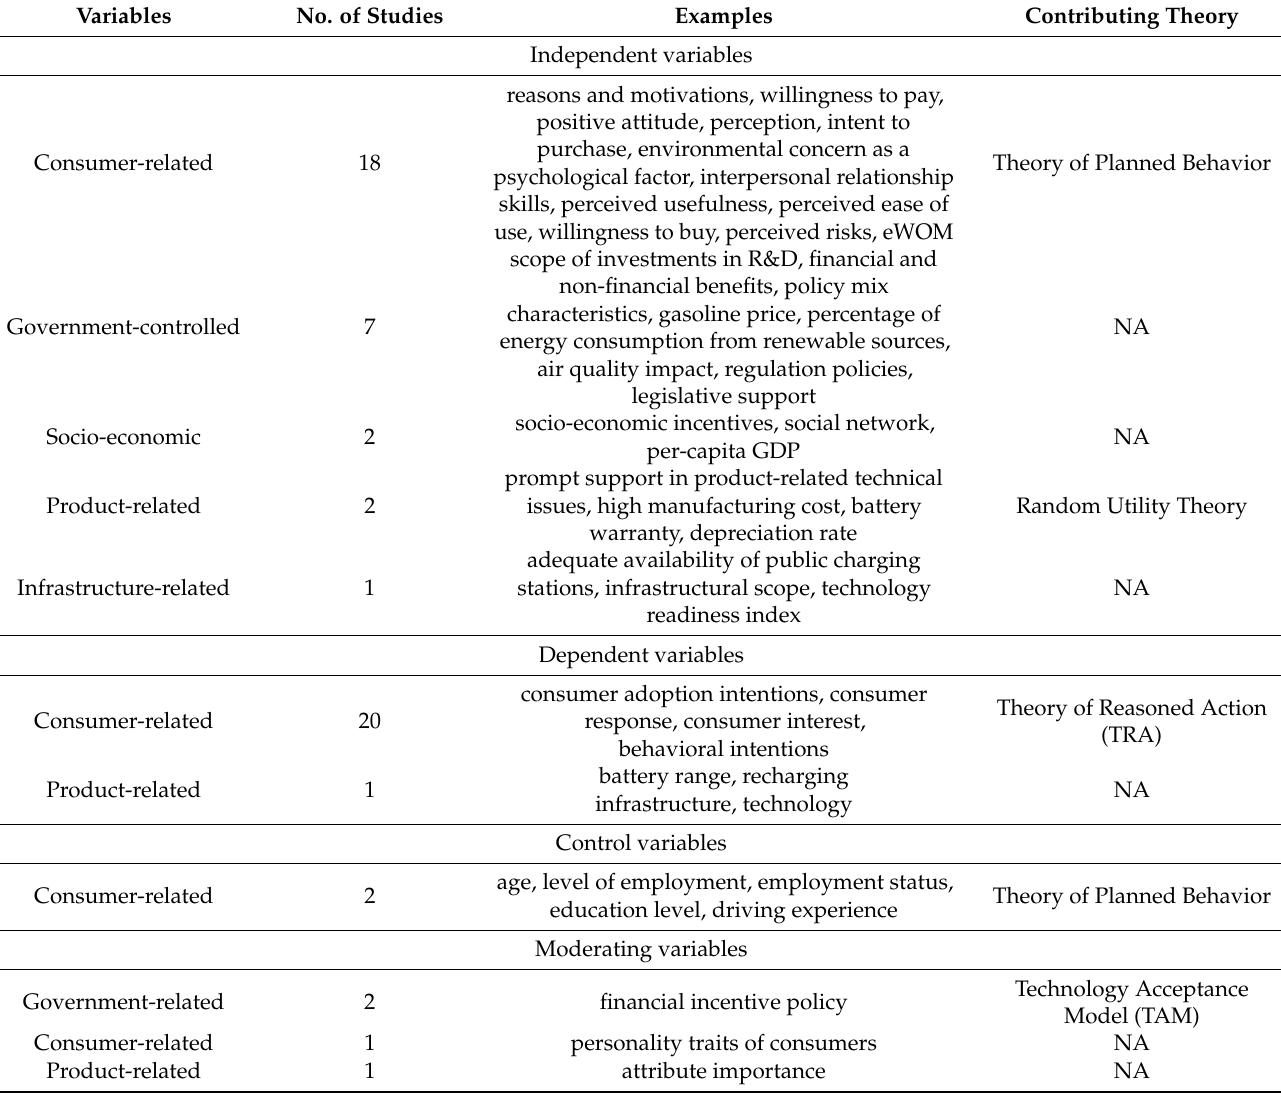
Table 6. Variables used in the reviewed studies on consumer adoption of electric